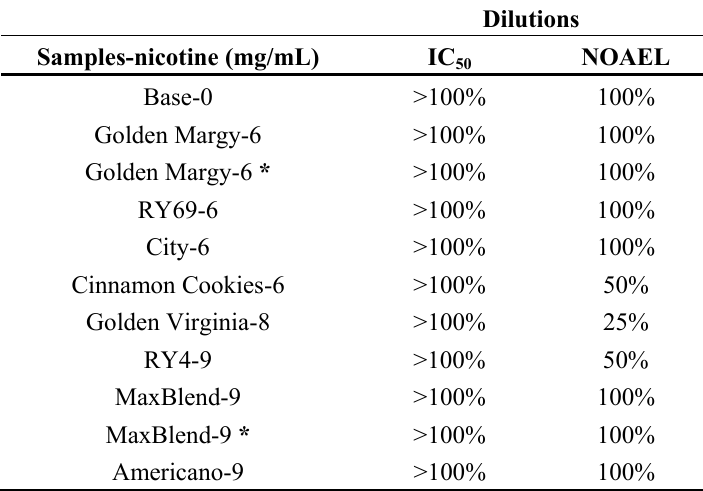
Table 5. Inhibitory concentration 50 (IC electronic cigarette extract and for cigarette smoke